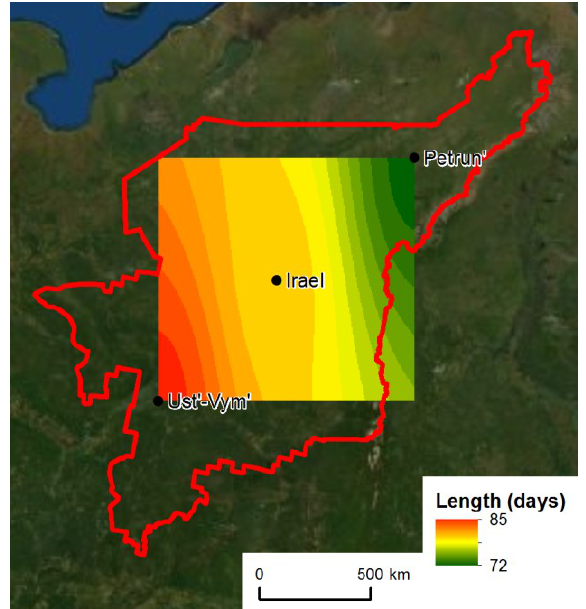
Figure 10. Lengths of summer growing season interpolated between meteorological